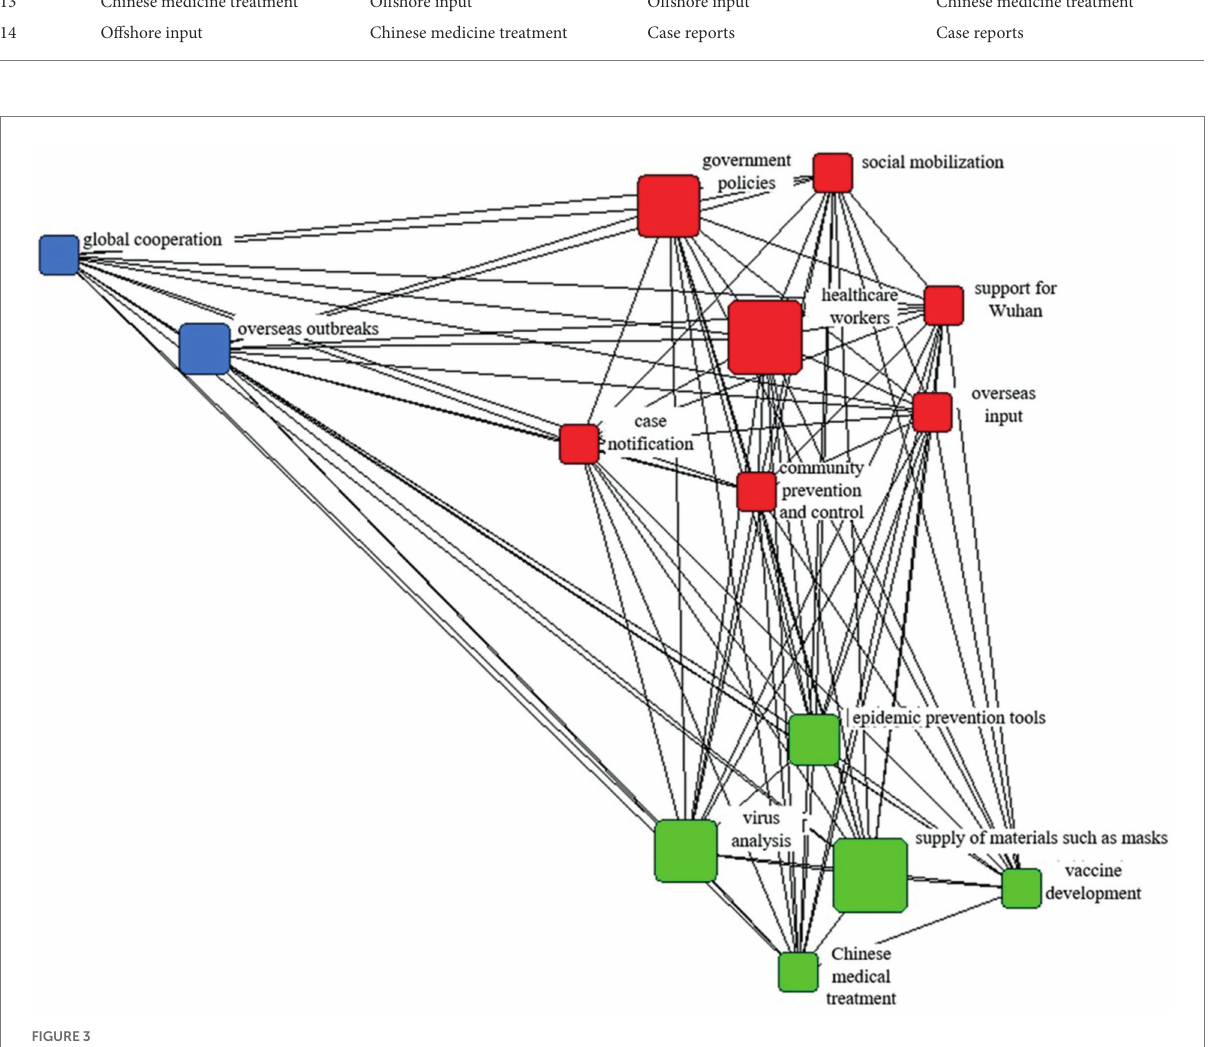
FIGURE 3 The agenda network of media